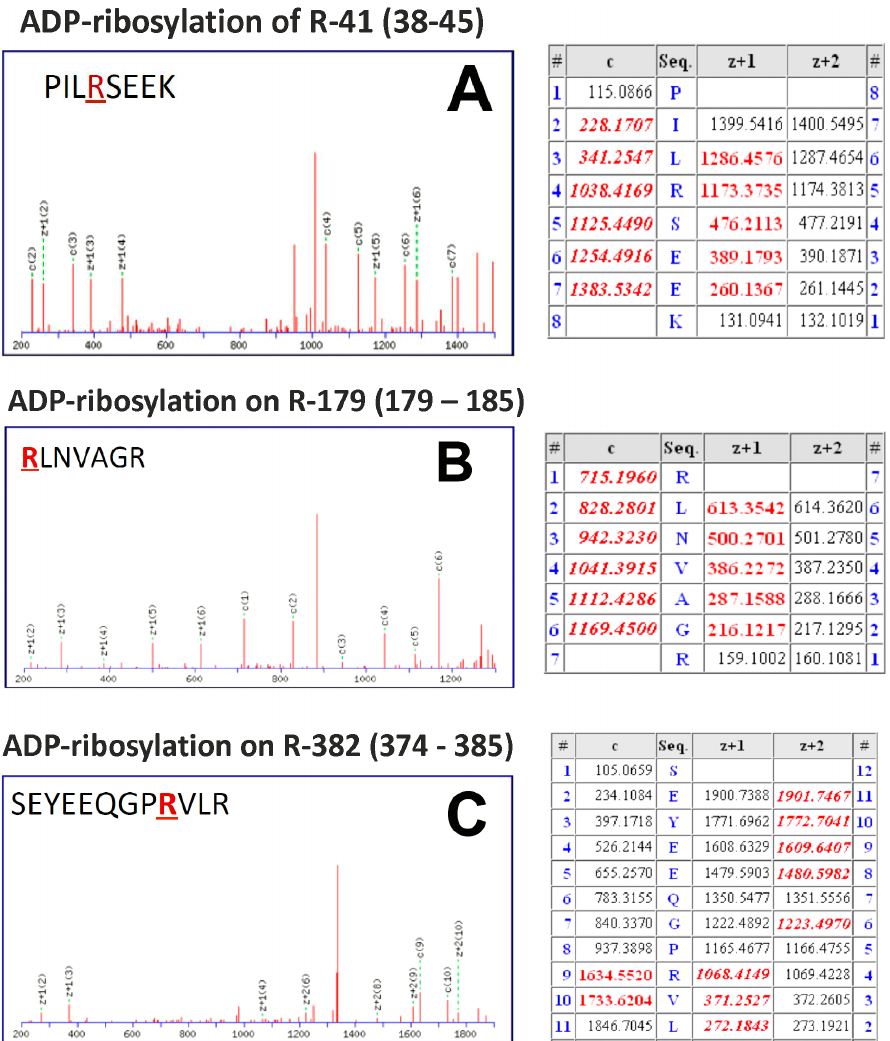
Figure 3. Mass spectrometric identification of ADP-ribosylation sites of Arp2. ADP-ribosylation sites were pinpointed from ETD spectra at positions R41, R179, and R382. Three peptides were identified: ( A ) ETD fragment ion mass spectrum of the peptide PILRSEEK (residues 179–185) with the ADP-ribosylated arginine at position 41; corresponding calculated fragment ion masses (c and z ions); values marked in red have been detected in the ETD spectrum. ( B ) ETD fragment ion mass spectrum RLNVAGR (residues 179–185) with the ADP-ribosylated arginine at position 179 and corresponding calculated fragment ion masses (c and z ions); values marked in red have been detected in the ETD spectrum. ( C ) ETD fragment ion mass spectrum of the peptide SEYEEQGPRVLR (residues 374–185) with the ADP-ribosylated arginine at position 382 and corresponding calculated fragment ion masses (c and z ions); values marked in red have been detected in the ETD spectrum. Peptide ( B ) containing arginine 179 was most prominently ADP-ribosylated.